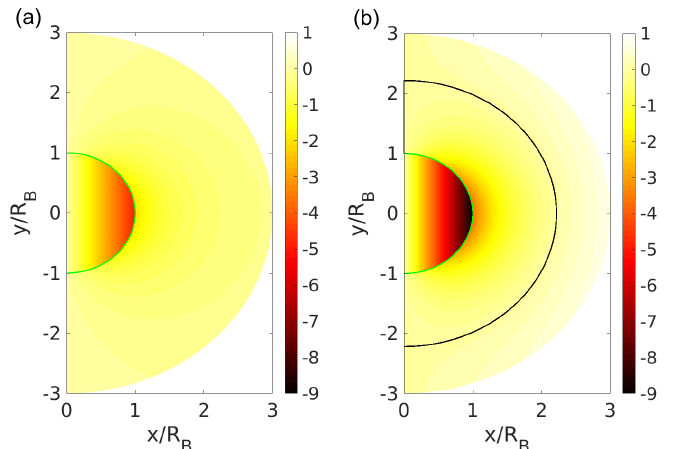
Figure 4. Plane-normal vorticity component in the bubble case ( ξ = 0.0182) with ( a ) far-field and ( b ) near-field boundary conditions ( r W = 3 r B ). The black line indicates the zero-vorticity